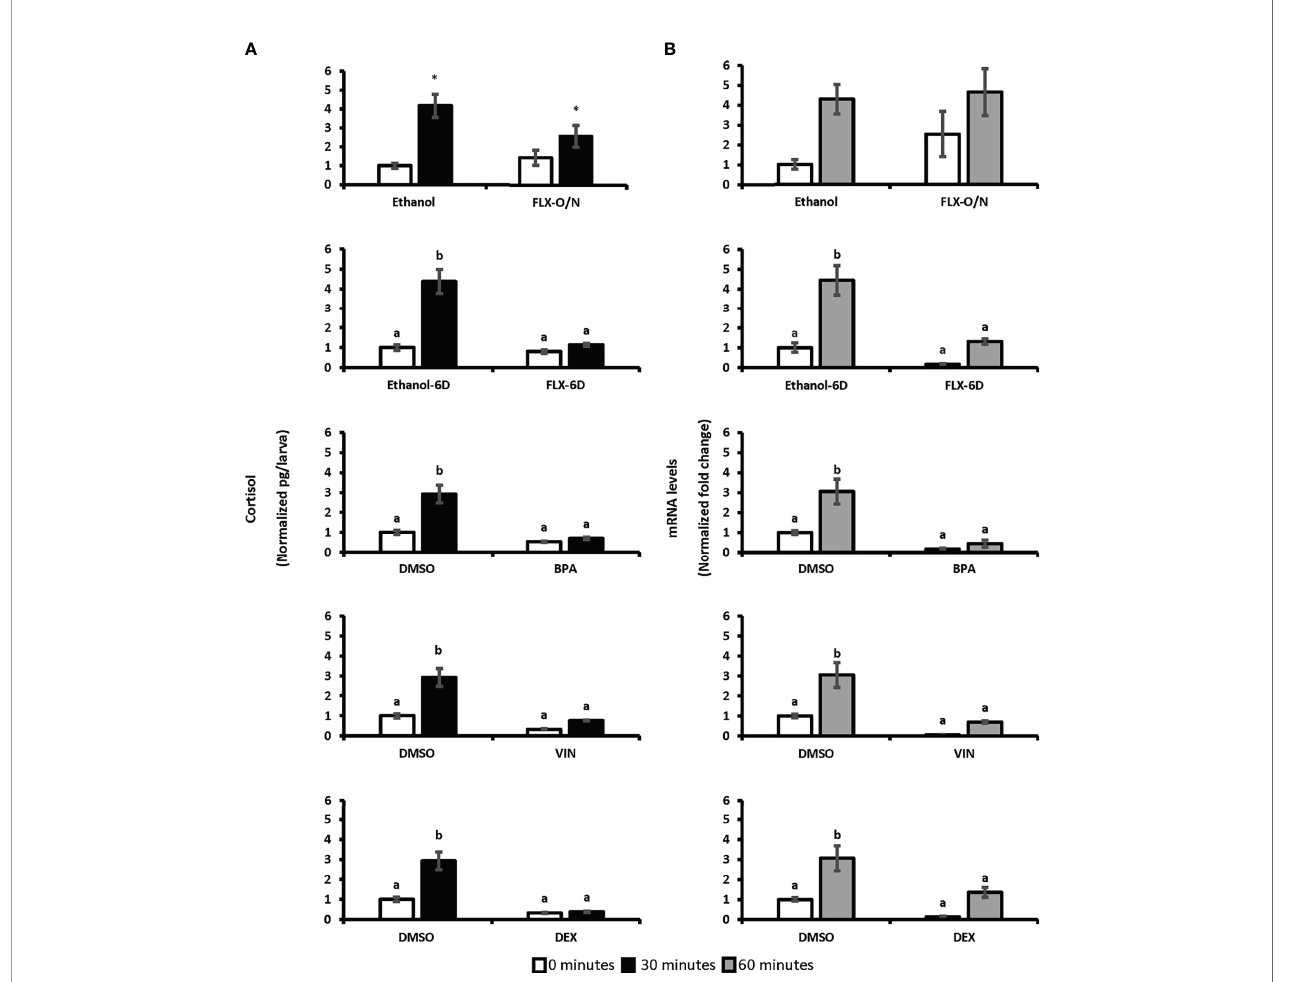
FIGURE 3 | Whole-body cortisol and eGFP mRNA levels in SR4G larvae exposed to different chemicals before and after handling stress. Panel (A) shows the whole-body cortisol (normalized pg/larvae) measured before and after the handling stress following exposure to different chemicals. The white bars represent cortisol levels in the unstressed condition (sacri fi cing subjects at 0 minutes before the handling stress) and the black bars represent cortisol levels 30 minutes after the handling stress. Panel (B) shows the eGFP mRNA levels (normalized fold change) measured before and after the handling stress following exposure to different chemicals. The white bars represent eGFP mRNA levels in the unstressed condition (sacri fi cing subjects at 0 minutes before the handling stress) and the gray bars represent eGFP mRNA levels 60 minutes after the handling stress. Two-way ANOVA was performed between each treatment group and its related control group in both unstressed and stressed state. No statistical comparison was performed between different treatment groups. Tukey ’ s post-hoc test followed the signi fi cant ANOVA results for pairwise comparisons. Means (± SEM) with different letters (a, b) are signi fi cantly different; p ≤ 0.05; N=6. Each sample contained a pool of 22-28 7dpf SR4G transgenic zebra fi sh larvae. Ethanol was used as the vehicle for FLX with a fi nal concentration of 0.005%. DMSO was used as the vehicle for BPA, VIN, and DEX with a fi nal concentration of 0.001%. The DMSO data in each graph is the same data portrayed for comparison purposes. FLX-O/N, overnight exposure to fl uoxetine; FLX-6D, daily exposure to fl uoxetine from 0 to 6 days post fertilization(dpf); Ethanol-O/N, overnight exposure to ethanol; Ethanol-6D, daily exposure to ethanol from 0dpf to 6dpf; BPA, overnight exposure to bisphenol A; VIN, overnight exposure to vinclozolin; DEX, overnight exposure to dexamethasone; DMSO, overnight exposure to DMSO. *Signi fi cantly different (p<0.05) compared to unstressed state but not signi fi cant in 2-way